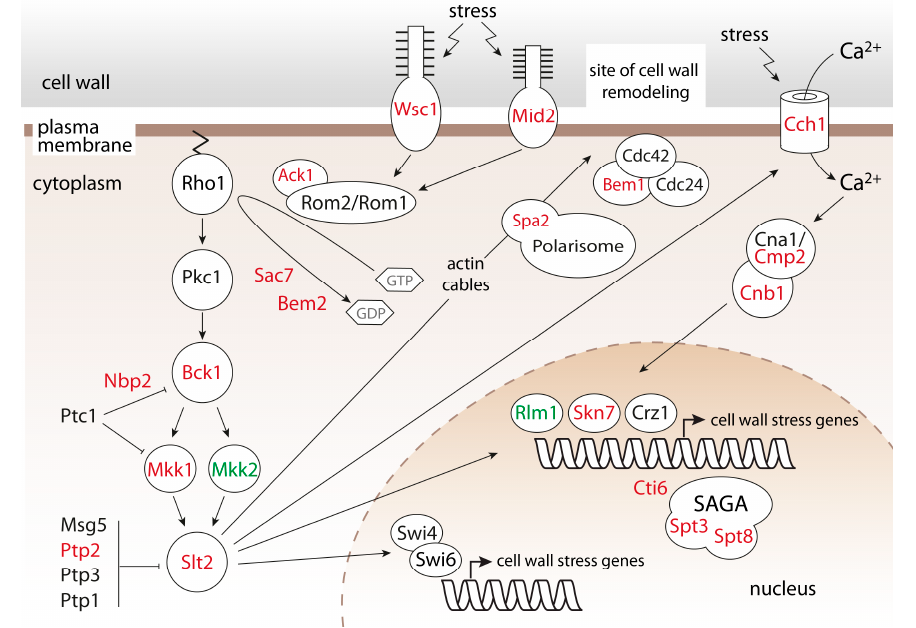
Figure 5. Scheme representing major factors of CWIP and the calcineurin signaling pathway. Impaired O -mannosylation results in severe growth defect in the absence of factors depicted in red (growth inhibition of 75% or more) and green (growth inhibition of 74% mkk2 ∆ and 73% rlm1 ∆ ). Details are described in Section 2.1. Our screening also revealed Ste20 and Tor1, involved in mating/filamentous growth/sterile vegetative growth signaling and in nutrient sensing, respectively (Supplementary Table S1).